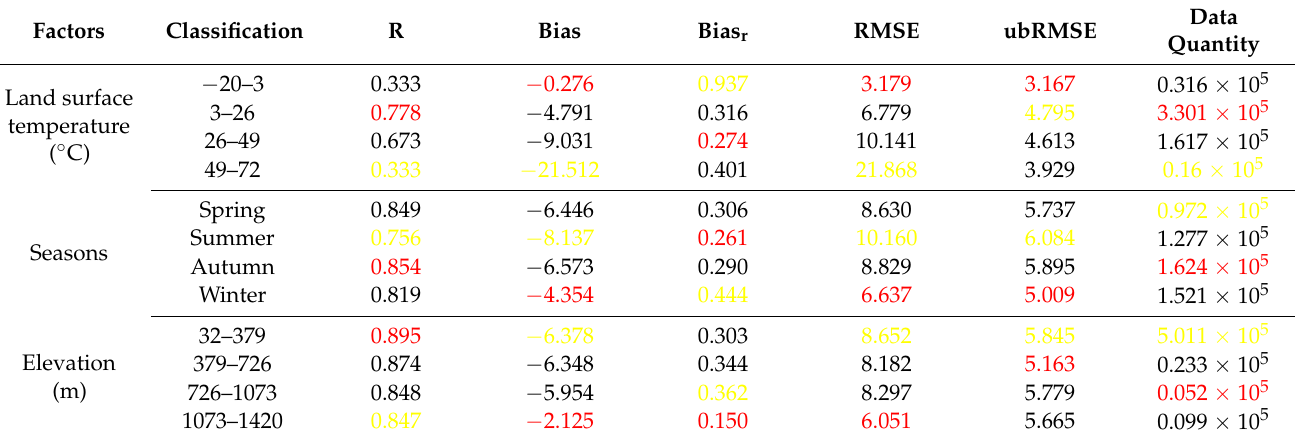
Table 3. Error indicators for comparison between FY-4A LST and in situ measurement of classifica- tions of different